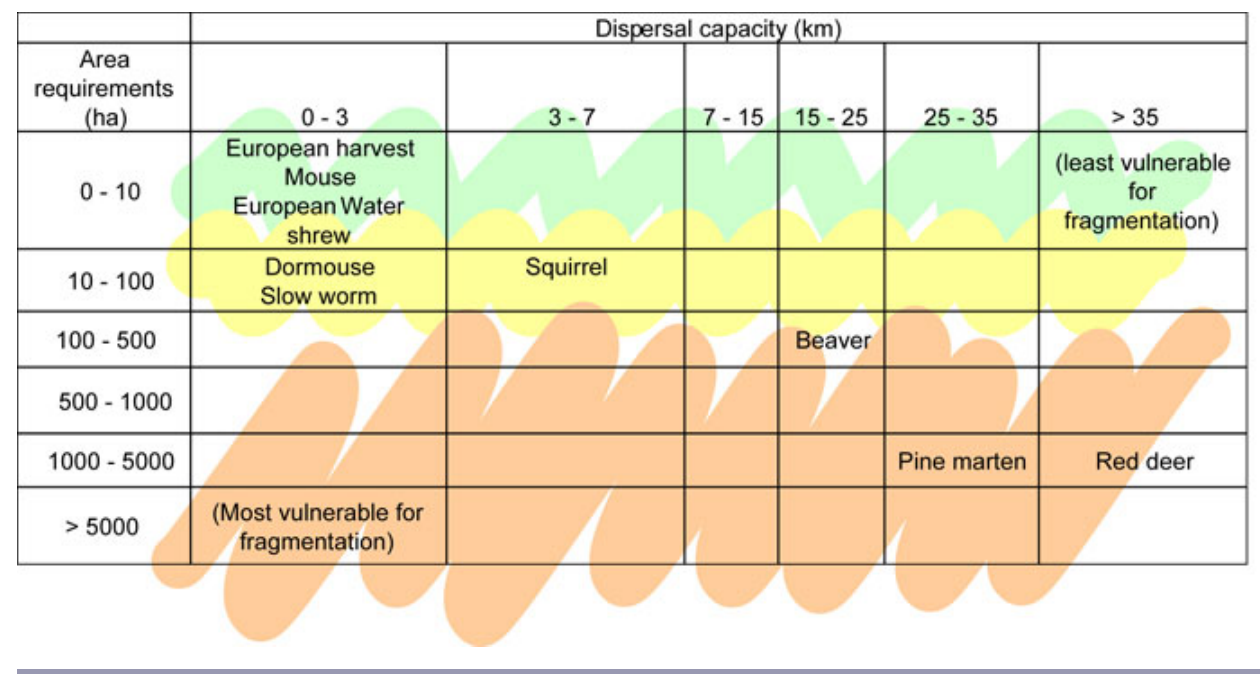
Fig. 4. An example of the use of woodland ecoprofiles sensitive to dispersal barriers (Cheshire Ecological network planning, van Rooij et al. (2003)). The species indicated were selected by the local stakeholder group. On the green background: ecoprofiles with a very sustainable habitat network covering most suitable areas in the study area; on the yellow background: ecoprofiles with potential for sustainable habitat networks in parts of suitable areas in the study area; on the red background: ecoprofiles with no potential for a sustainable habitat network in the study area; and inside the black frame: the selected target